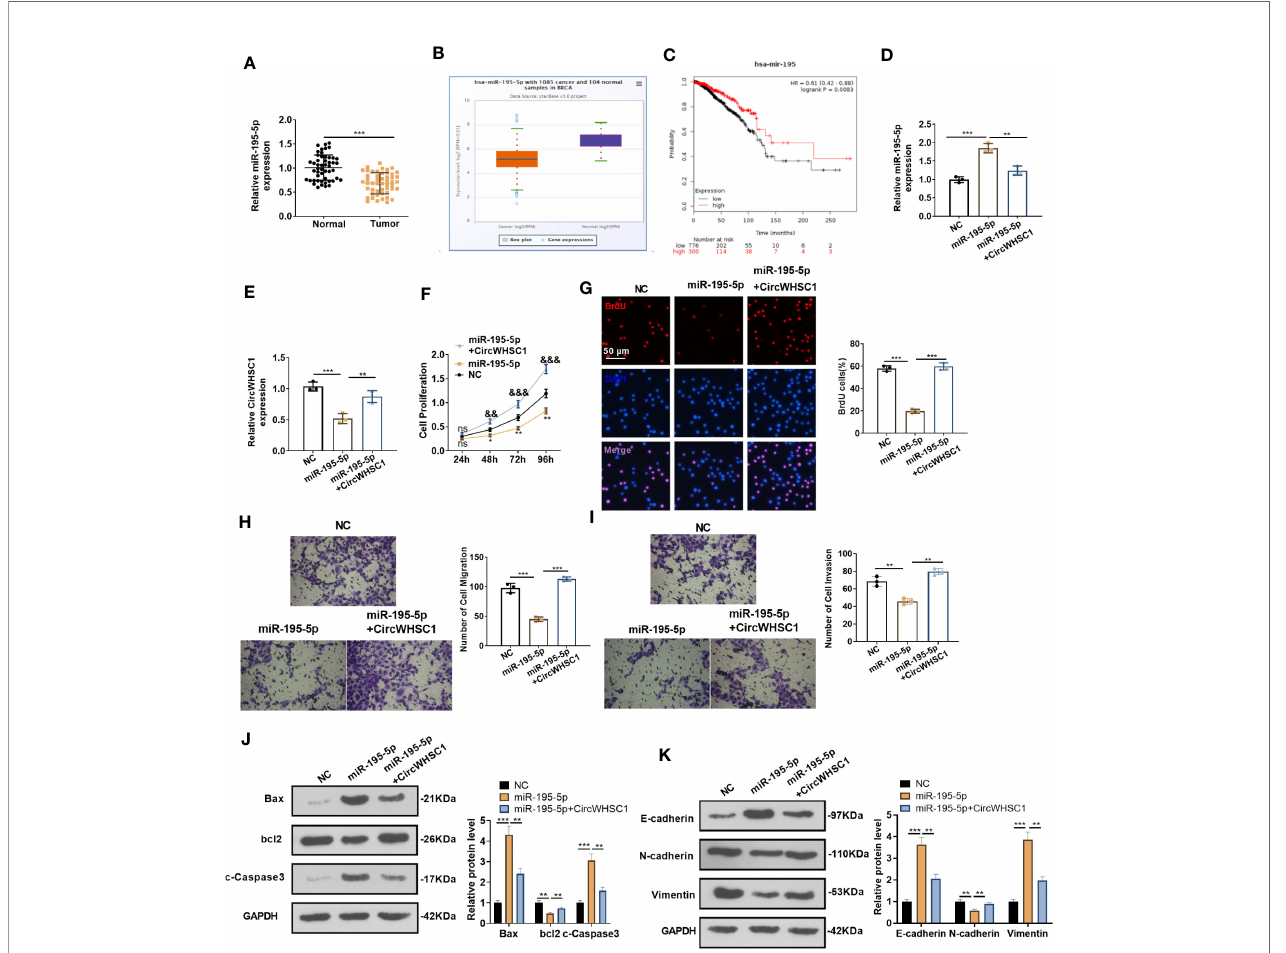
FIGURE 5 | miR-195-5p inhibited BC progression and was dampened by circWHSC1. (A) The miR-195-5p pro fi le in BC tissues was detected by qRT-PCR. (B) The expression of miR-195-5p in 1085 BC tissues and 104 non-tumor tissues was shown by Starbase. (C) Analysis of the link between miR-195 and BC prognosis via KMplotter database (http://kmplot.com/analysis/). (D, E) MCF7 cells were transfected with miR-195-5p mimics and circWHSC1 overexpressing plasmids, and qRT-PCR was carried out to determine the expression of miR-195-5p (D) and circWHSC1 (E) . (F) CCK-8 assay was used for detecting cell proliferation, ** P < 0.05, ** P < 0.01 (vs.NC group), && P < 0.01, &&& P < 0.001 (vs. miR-195-5p group). (G) BrdU assay evaluated cell proliferation. scale bar=50 m m. (H, I) Transwell assay determined MCF7 cell migration and invasion. (J, K) . WB was performed for evaluating the protein levels of Bax, bcl2,